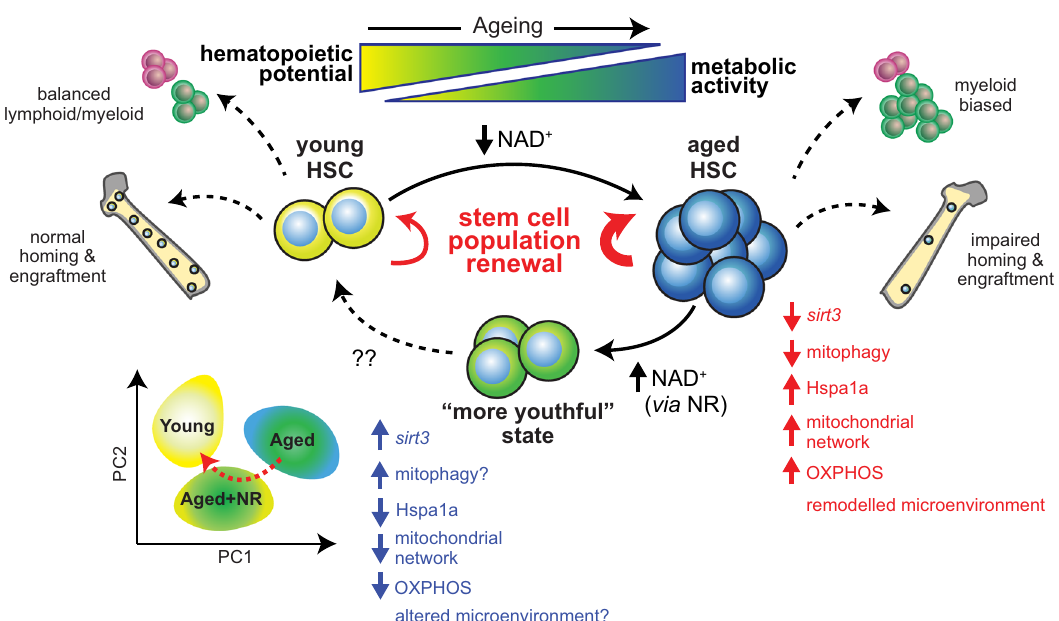
Fig. 8 Proposed model of the effects of NR treatment on aged HSC. With age, HSC undergo several changes including expansion of the stem cell pool, reduction in homing and engraftment potential and myeloid biased differentiation. These functional changes are associated with reduced Sirt3 expression and reduced mitophagy with a concomitant increase in the mitochondrial network and increased metabolism that is reliant on oxidative phosphorylation. These changes are underpinned by the altered transcriptional programme of aged HSC. Repletion of the age-associated decrease in NAD levels in HSC via nicotinamide riboside (NR) results in a reduction of the HSC pool as well as changes in the transcriptional programme of aged HSC towards a “ more youthful ” state and is associated with improved engraftment and partial reversion of the myeloid bias following transplantation of HSC isolated from NR- treated aged mice. These effects may be driven by increased Sirt3 expression, reduced levels of Hspa1a and decreased metabolism through oxidative phosphorylation as well as increased mitophagy, which results in a reduction of mitochondrial network and